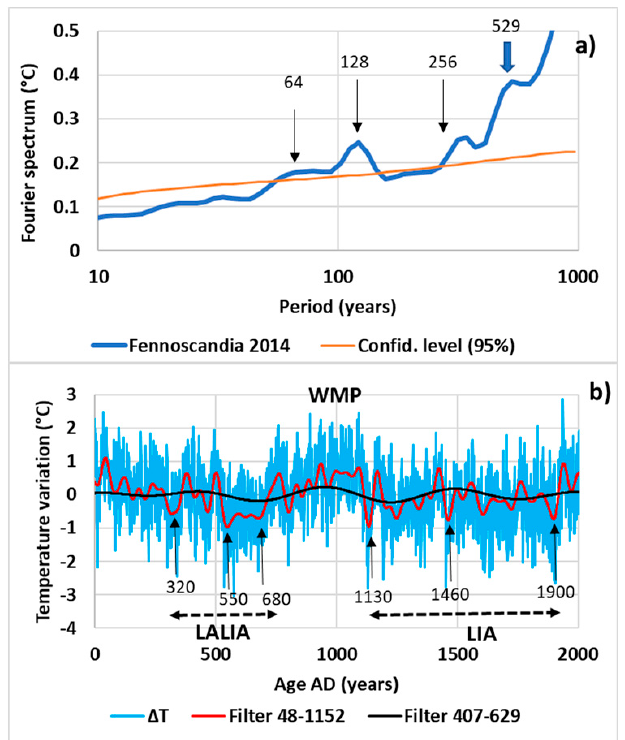
Figure 4. Northern Fennoscandia 2000-years June–July temperature reconstruction; ( a ) Fourier spectrum and 95% confidence level; ( b ) raw and filtered temperature variation in the 48-1152 and 407–629 year bands.